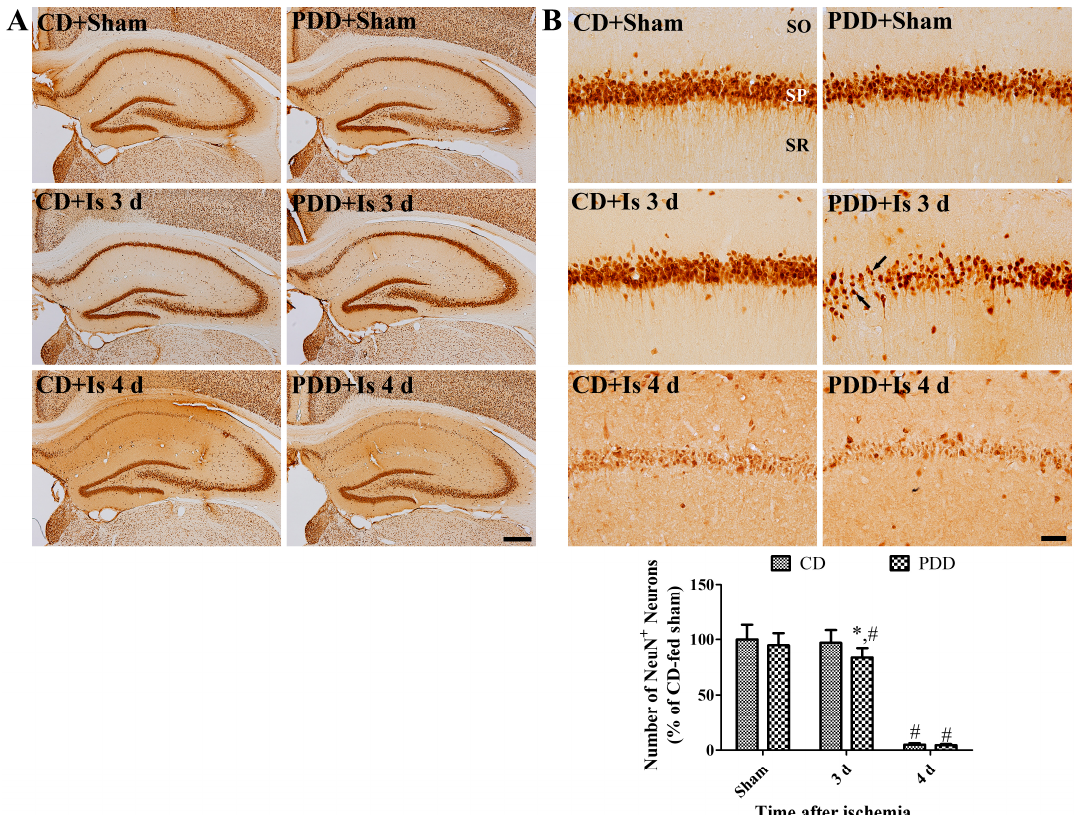
Figure 2. Immunohistochemical staining for neuronal nuclei (NeuN) in the whole hippocampus ( A ) and its magnified CA1 region ( B ) in the CD- and PDD-fed gerbils of sham- and ischemia-operated groups. Note that fewer NeuN-positive cells (arrows) are found in the medial side of the stratum pyramidale (SP) in the PDD-fed gerbils three days after ischemia. SO, stratum oriens; SR, stratum radiatum. Scale bar = 400 μ m ( A ), 50 μ m ( B ). The number of NeuN-immunoreactive nuclei in the CA1 region compared to the CD-fed sham group per section, in all the groups, is shown ( n = 7 per group; * p < 0.05, significant difference between CD- and PDD-fed group; # p < 0.05, significant difference between sham- and ischemia-operated groups). All data are expressed as mean with standard deviation.